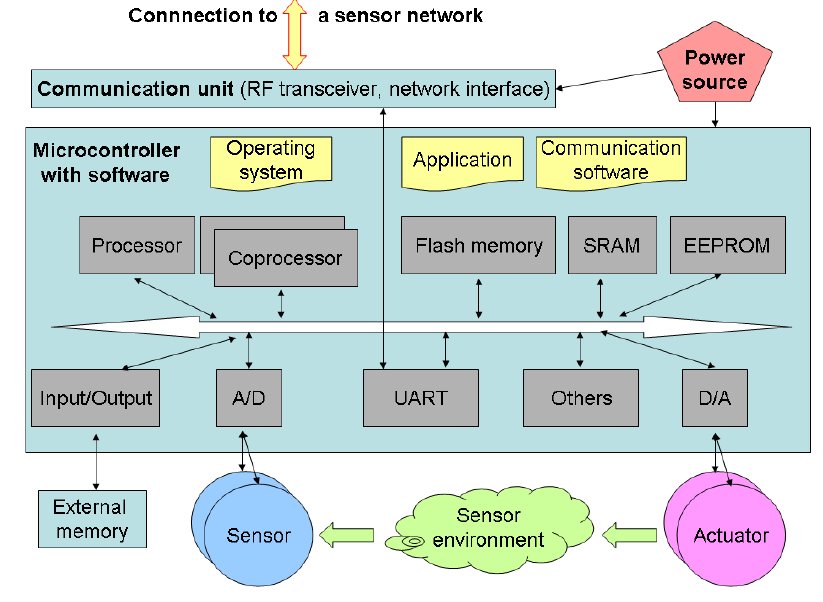
Figure 1. Generalized model of the intelligent sensor used for security analyses during the IT security development